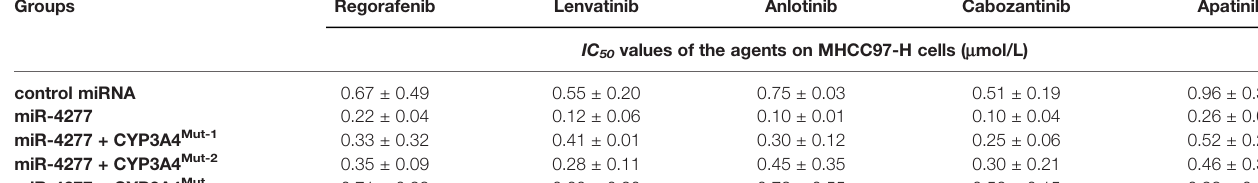
TABLE 3 | miR-4277 enhanced the sensitivity of MHCC97-H cells to molecular targeted agents, regorafenib, lenvatinib, anlotinib, cabozantinib, or apatinib. Groups